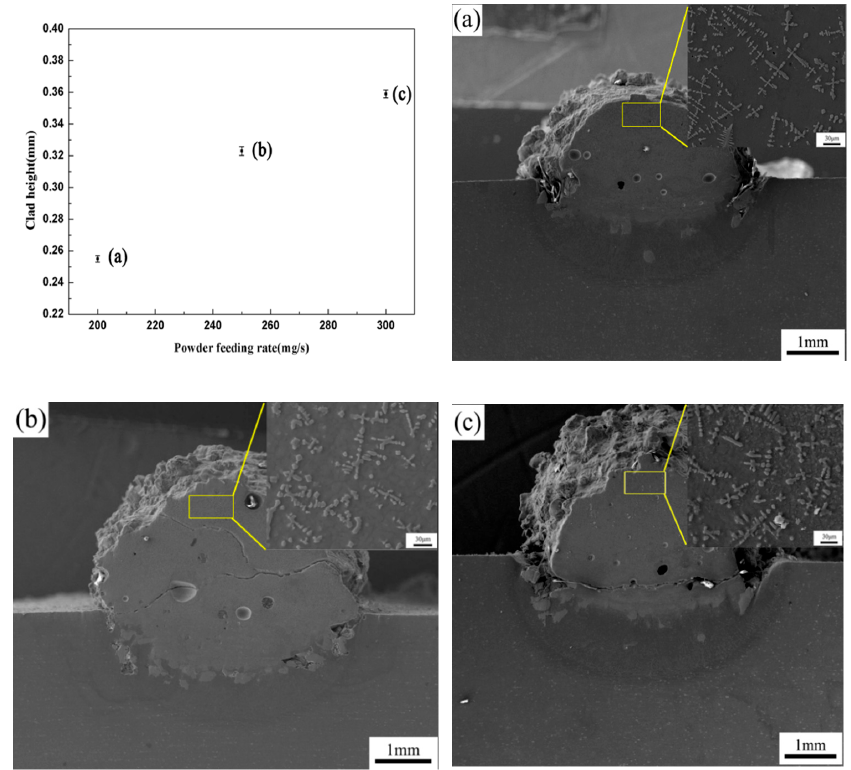
Figure 3. The clad height and microstructure of single clad tracks in different powder feeding rate (F). ( a ) the powder feeding rate of 200 mg/s; ( b ) the powder feeding rate of 250 mg/s; ( c ) the powder feeding rate of 300 mg/s.